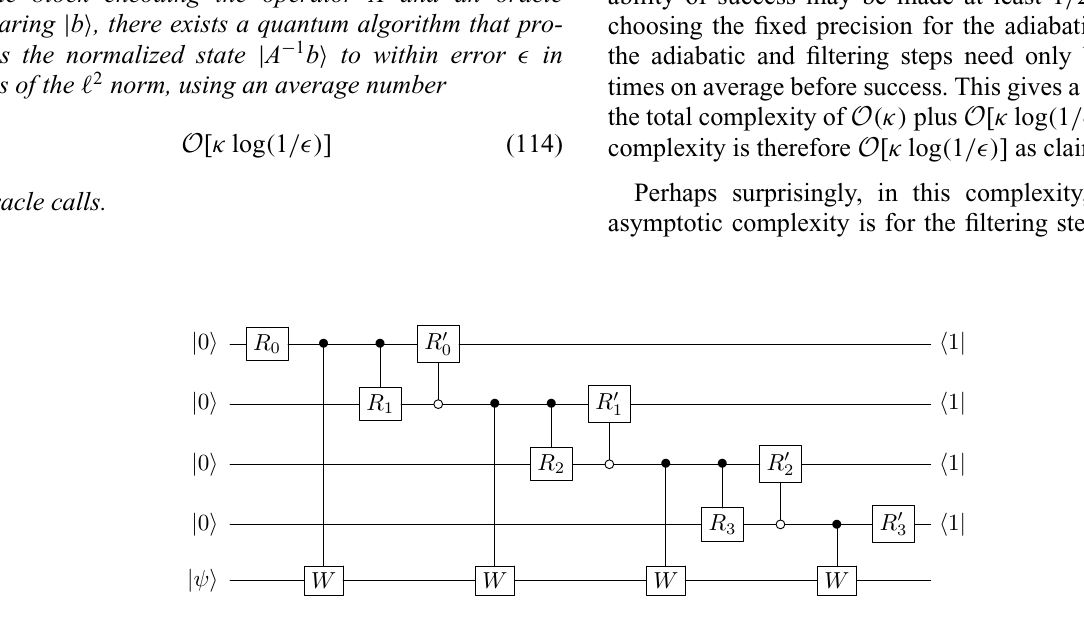
FIG. 6. A linear combination of steps using control registers prepared in unary but with the order of the operations changed so that we only need to use two ancilla qubits at a